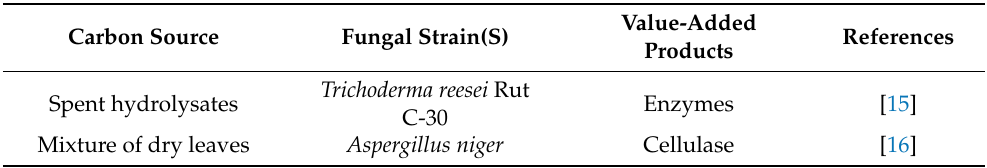
Table 1. Examples of complex carbon sources for the production of value-added products from fungal fermentation